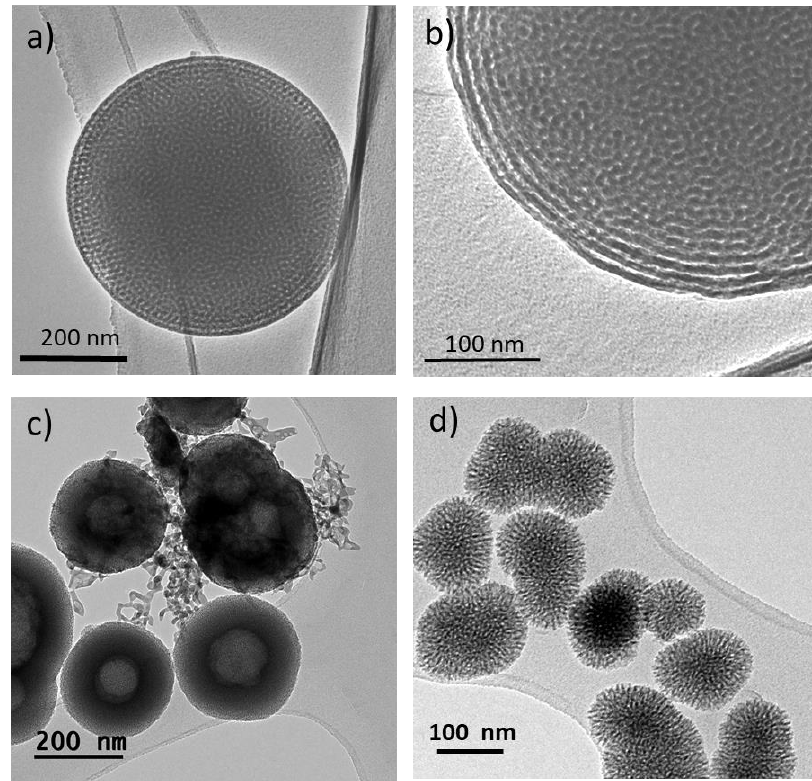
Figure 3. Different examples of MBNPs prepared by different methods. Hexagonal ordered ( a ) and lamellar ( b ) mesoporous nanoparticles prepared by aerosol-assisted pyrolysis; ( c ) core – shell MBNPs